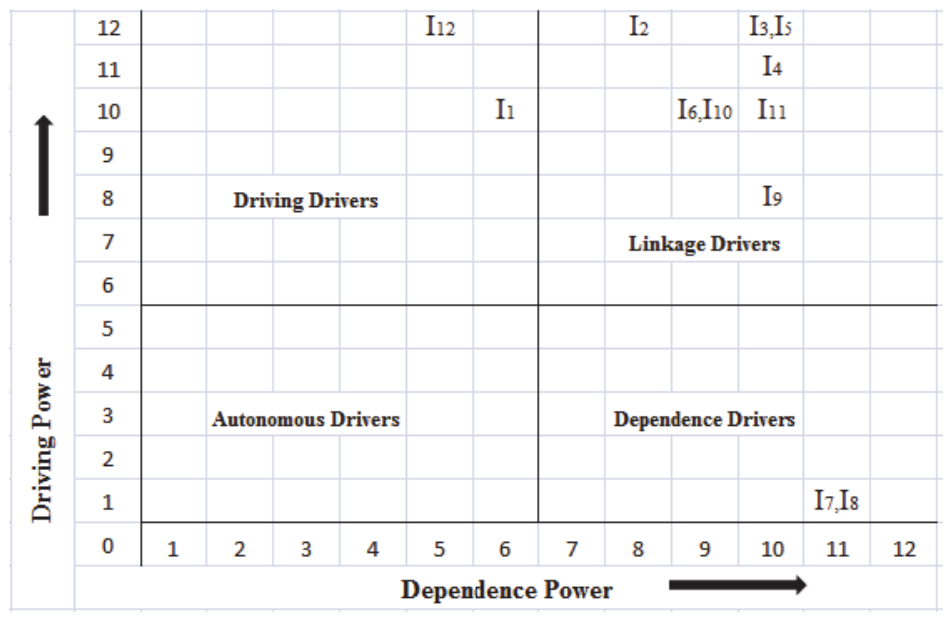
Fig. 5. The driving or dependence power for the